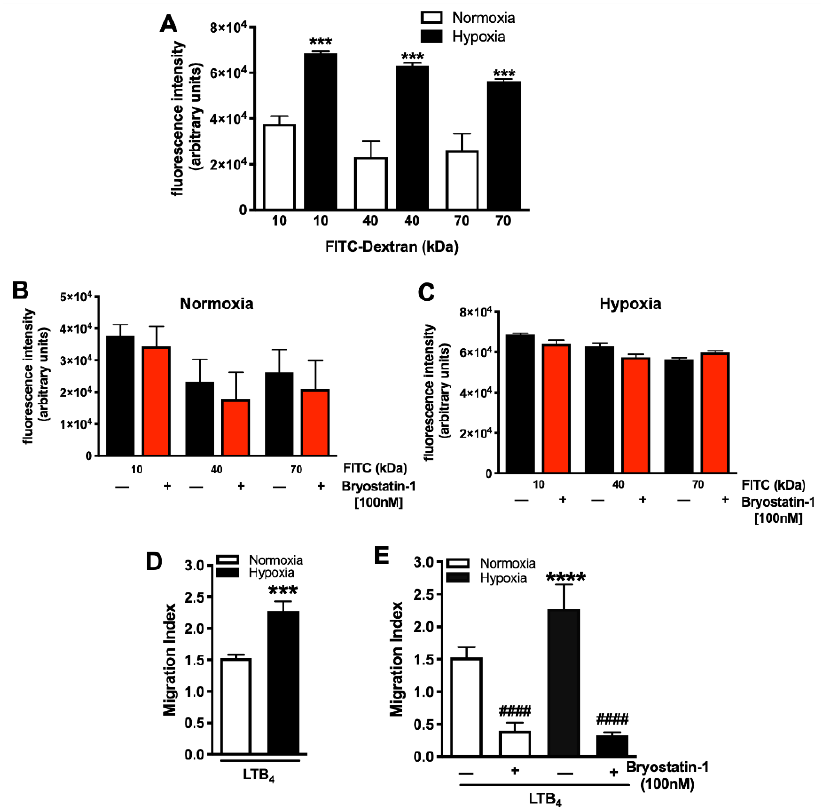
Figure 2. Bryostatin-1 prevents hypoxia-elicited endothelial permeability and blocks neutrophil transmigration. Confluent human umbilical vein endothelial cell (HUVEC) monolayers were subjected to either normoxia (21% O 2 , 5% CO 2 , and 74% N 2 ) or hypoxia (2% O 2 , 5% CO 2 , and 73% N 2 ) followed by normoxia, and ( A ) FITC-dextran (10 and 40 kDa) permeability was measured. Hypoxia induced a significant increase in HUVEC permeability for FITC, irrespective of the molecular size. ( B ) HUVEC monolayers were treated with 100 nM Bryostatin-1 or vehicle (1 X PBS), and permeability for FITC- dextran (10, 40, and 70 kDa) was tested under ( B ) normoxic or ( C ) hypoxic conditions. ( D ) Neutrophil transmigration across confluent HUVEC monolayers toward leukotriene B4 (LTB 4 , 10 − 6 M) was measured under normoxic and hypoxic conditions, showing a hypoxia-elicited increase in neutrophil transmigration. ( E ) Treatment with Bryostatin-1 (100 nM) blocked neutrophil transmigration under normoxic and hypoxic conditions. The migration index was calculated by dividing the number of calcein-AM labeled neutrophils that migrated to LTB 4 by the number of cells that migrated to the vehicle. All results are representative of at least three independent experiments (n = 3–7). Graphs present mean ± SEM, and data were analyzed with ANOVA with Bonferroni post-tests ( A – C , E ) or Student’s t -test ( D ). Significance is indicated by the following symbols: ( A , D ) **** p < 0.0001